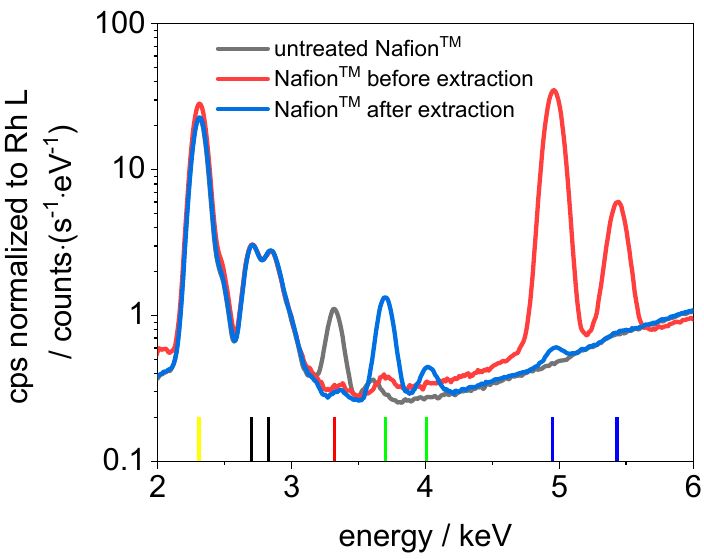
Figure 5. Sum spectra of untreated Nafion™, Nafion™ before and after extraction (normalized on Rh L). Vertical reference lines: yellow: S K α , black: Rh L α and L β , red: K K α , green: Ca K α and K β , and blue: V K α and K β .